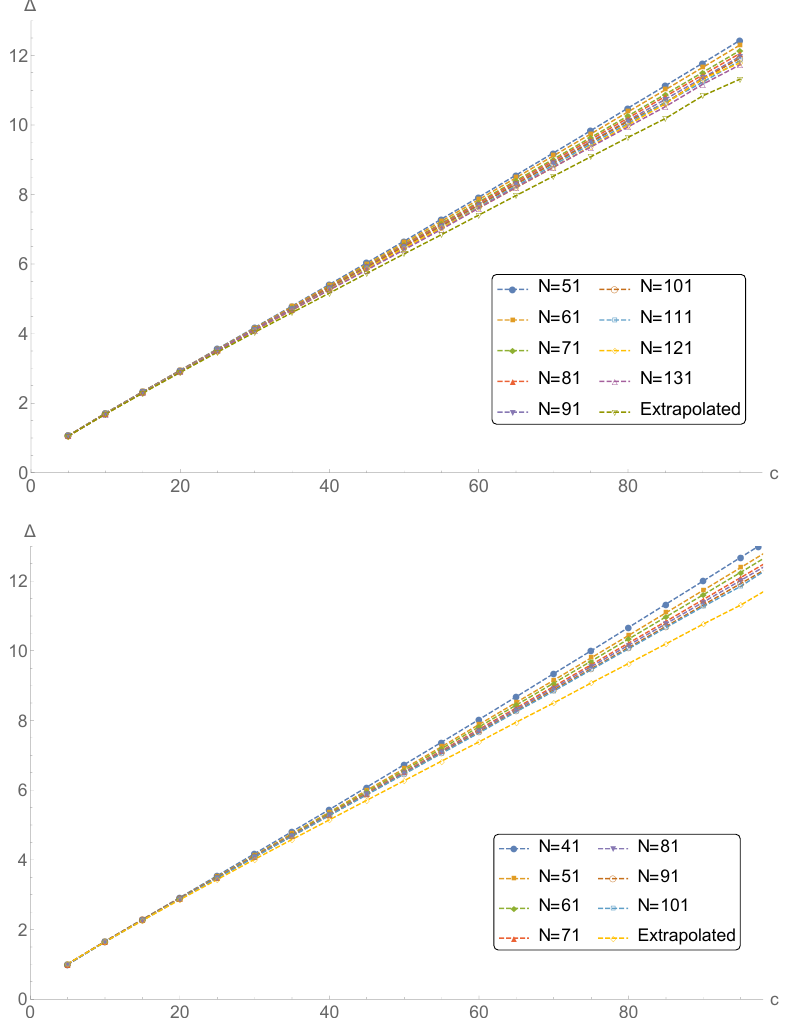
Figure 4 . The spin-independent bound on the lowest primary for the N = (1 ; 1) (upper) and N = (2 ; 2) (lower) SCFTs. The upper bounds decrease as we increase the parameter N for the linear functional (cid:11) from 51 to 131. The stringiest bounds represent the extrapolated result at each c , to N ! 1